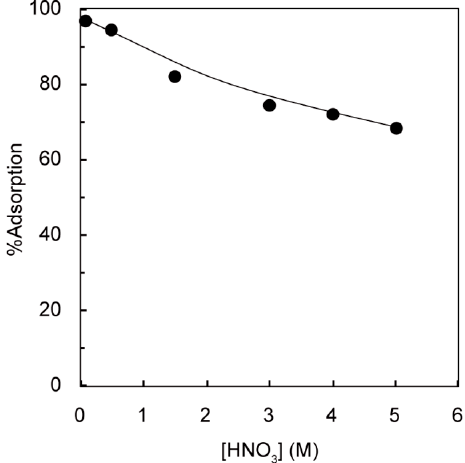
Figure 1. Effect of HNO 3 concentration on the recovery of Ag(I) using the PEI ‐ microalgae. Conditions: Ag(I) concentration = 0.2 mM, weight of adsorbent = 10 mg, volume of test solution = 10 mL, temperature = 30 °C, and shaking time = 24 h. Materials 2017 , 10 , 636